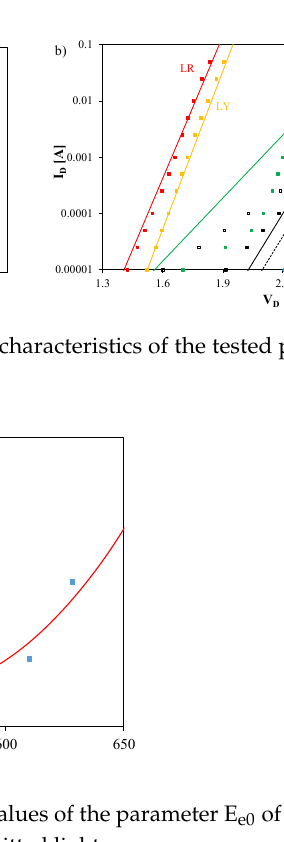
Figure 5. Dependence of the estimated values of the parameter E e0 of the investigated power LEDs on the central wavelength λ max of the emitted light.